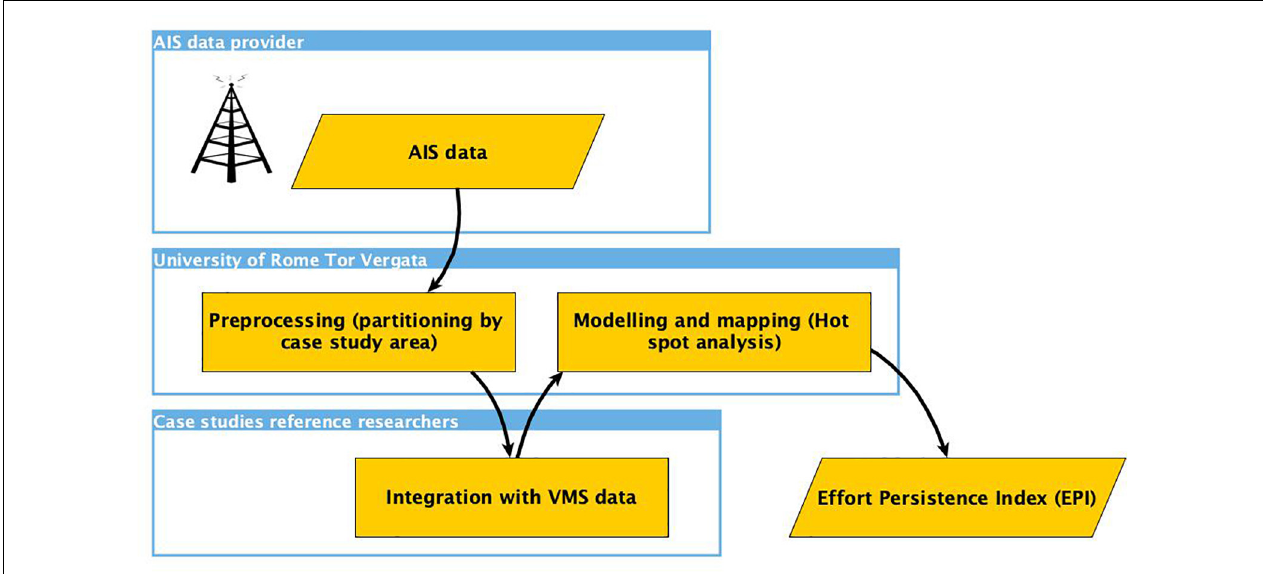
FIGURE 2 | Representation of the processing for the integration of AIS and encrypted VMS data. The process involved UTV and the Case Studies Reference researchers through a one-to-one data